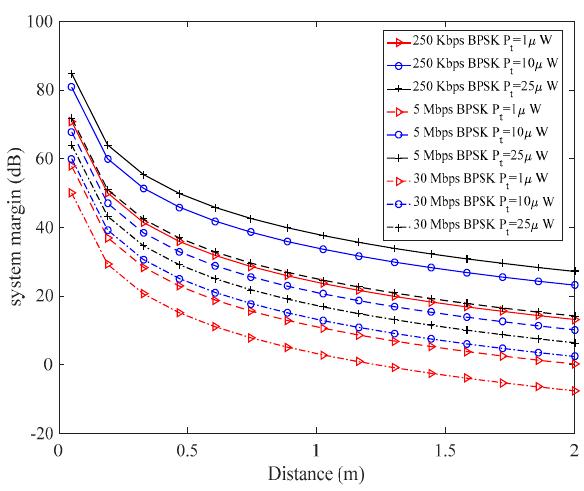
Figure 8. Link margin versus distance for 16PSK at multiple levels of data rates and powers.